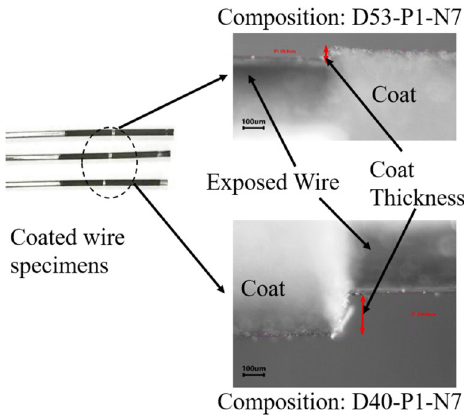
Figure 14. Micrographs of coated wire and coating thickness measurement for composition D53-P1-N7 (top) and D40-P1-N7 (bottom).